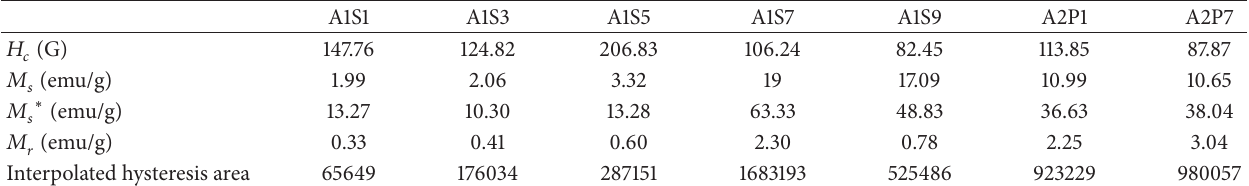
Table 5: Magnetic parameters of the